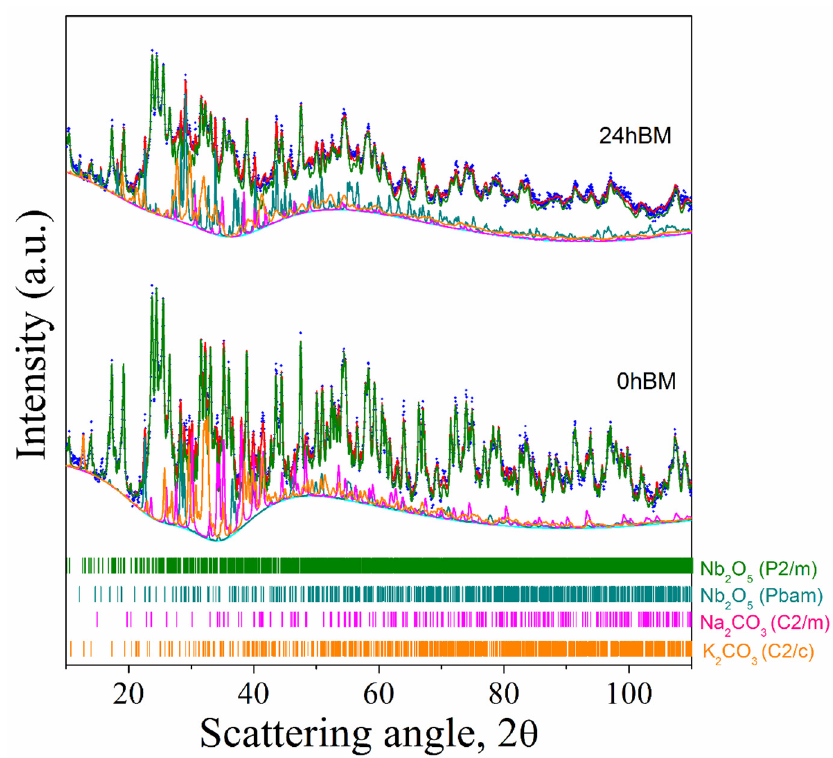
Figure 1. XRD pattern of the reaction mixture before (0 h BM) and after (24 h BM) the mechanical treatment. Blue dots are experimental data points, cyan lines are the background, red lines are the full calculated pattern and colored lines represent the contribution of each phase to the theoretical model used for the calculation.